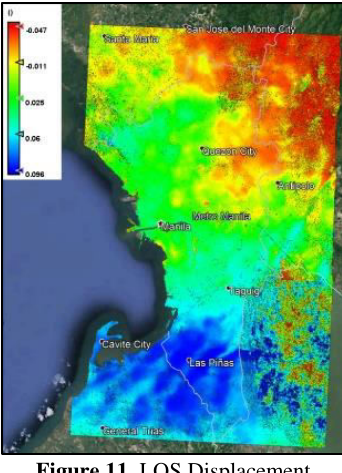
Figure 11. LOS Displacement